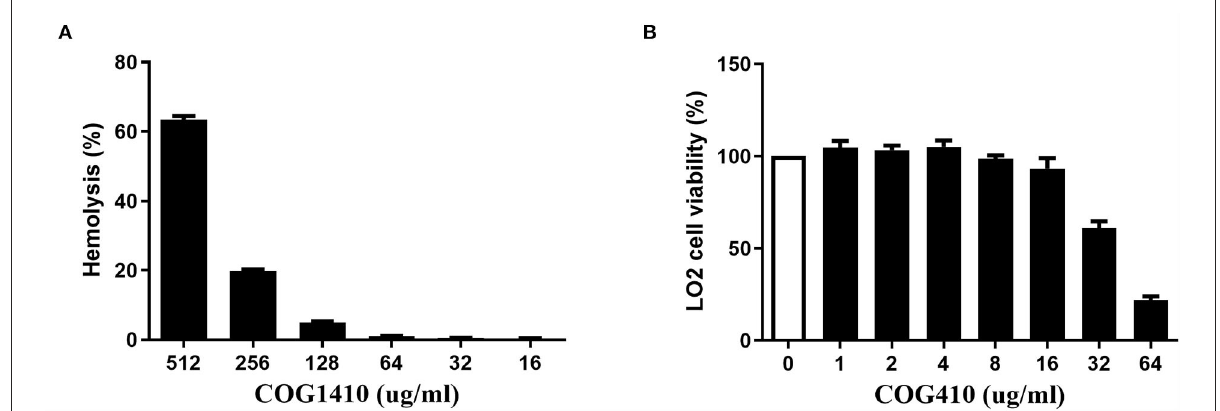
FIGURE6 COG1410 exhibited low hemolytic activity and medium cytotoxicity. (A) The hemolytic activity was determined by measuring the release of hemoglobin by human erythrocytes at 414nm, which were exposed to different concentrations of COG1410. PBS and Triton X-100 (0.1%) were used as negative and positive controls, respectively. (B) The cytotoxicity of COG1410 was evaluated by measuring the cell viability of normal human hepatic L02 cells treated with the increasing concentration of peptide using the CCK8 assay. Experiments were conducted in triplicate. Data indicated mean ± SD values.